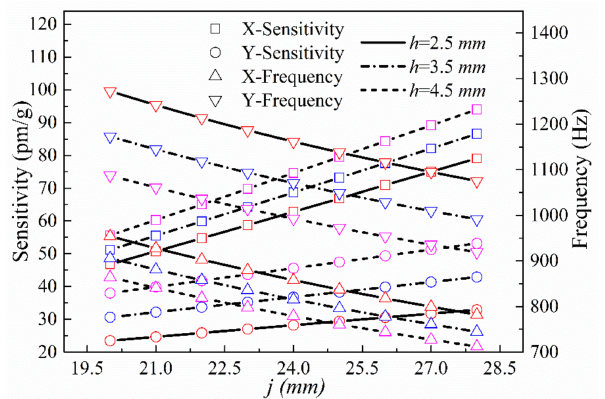
Figure 11. Sensitivities and natural frequencies in the x- and y-directions as a function of j at different values of h.